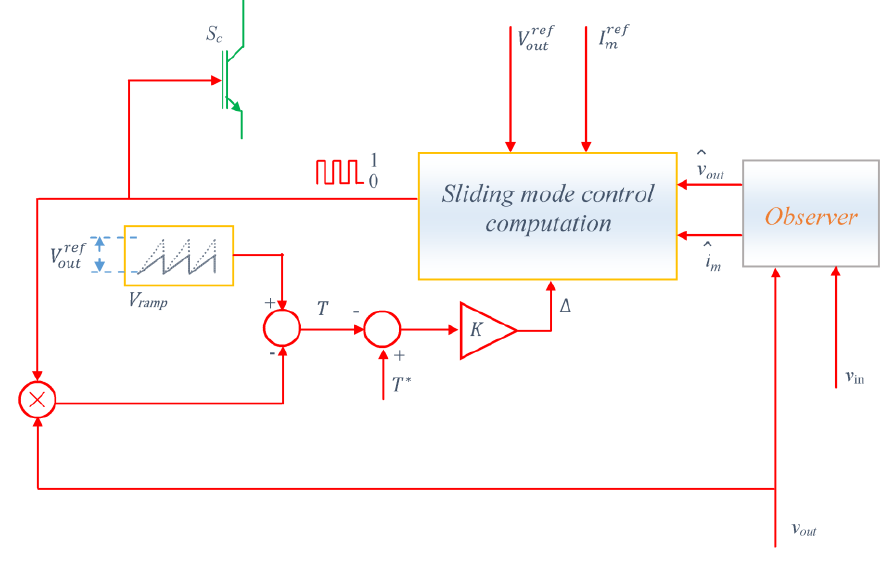
Figure 8. Architecture of the control strategy.